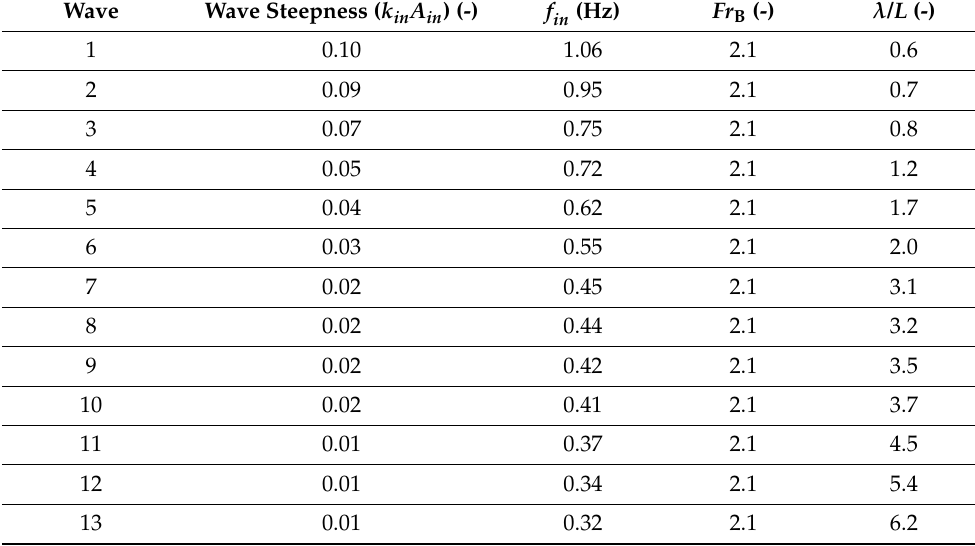
Table 3. Forcing condition of the first set of numerical experiments. Wave Table 4. Forcing condition of the second set of numerical experiments. Wave